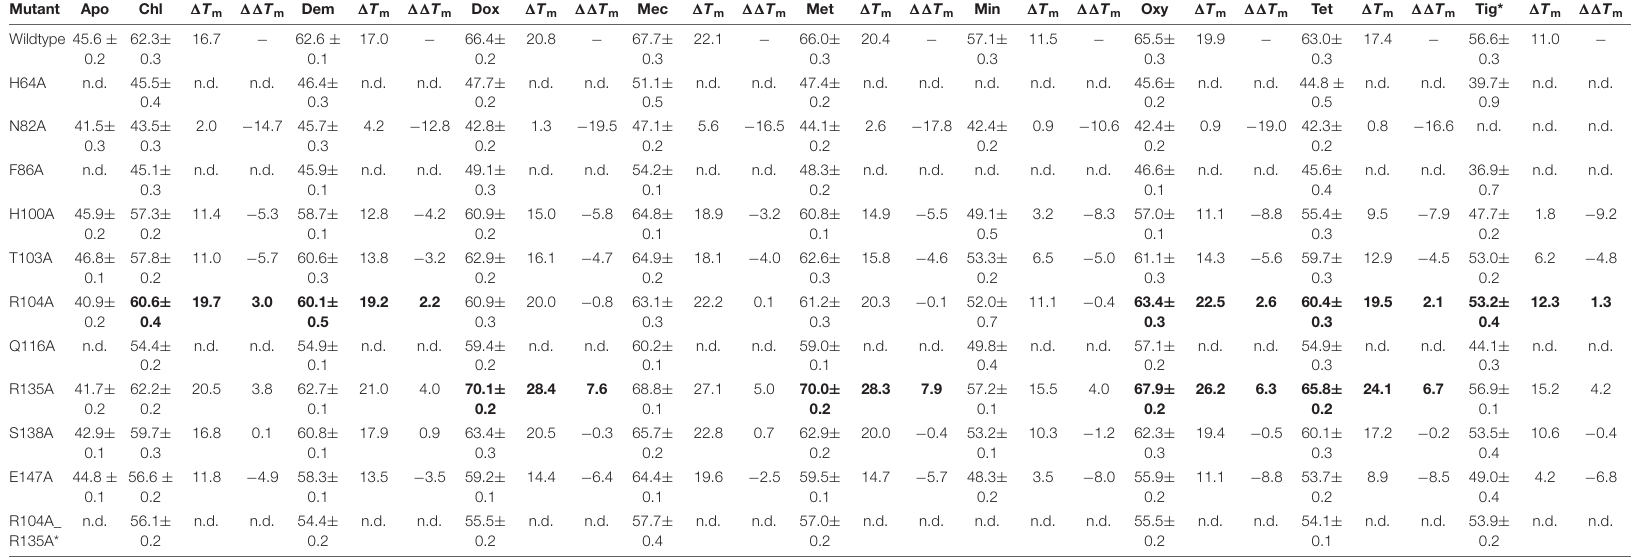
TABLE 1 | Melting temperatures of AbTetR variants in the absence or presence of various tetracycline antibiotics. Mutant Apo Chl (cid:49) T m (cid:49)(cid:49) T m Dem (cid:49) T m (cid:49)(cid:49) T m Dox (cid:49) T m (cid:49)(cid:49) T m Mec (cid:49) T m (cid:49)(cid:49) T m Met (cid:49) T m (cid:49)(cid:49) T m Min (cid:49) T m (cid:49)(cid:49) T m Oxy (cid:49) T m (cid:49)(cid:49) T m Tet (cid:49) T m (cid:49)(cid:49) T m Tig* (cid:49) T m (cid:49)(cid:49) T m Wildtype 45.6 ± 62.3 ± 0.2